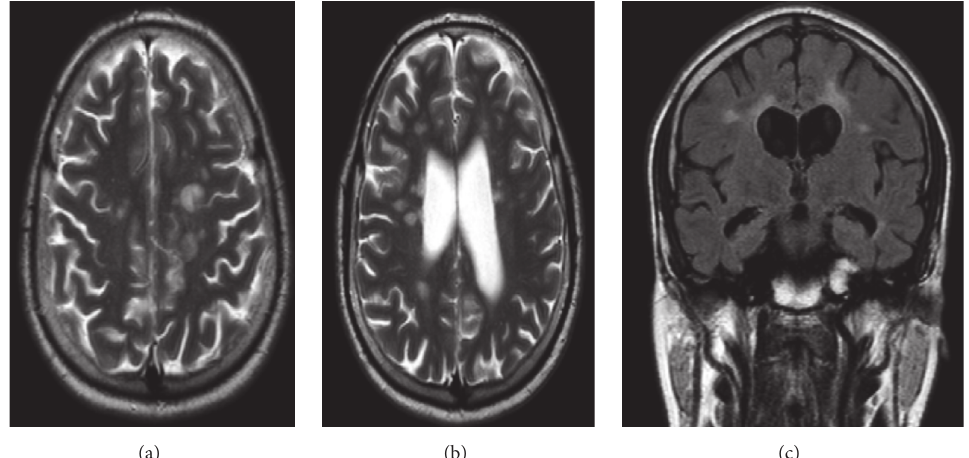
Figure 2: (a and b) Axial T2 MRI shows multiple periventricular and juxtacortical high intensity lesions. (c) Coronal flair MRI shows periv- entricular and juxtacortical high intensity